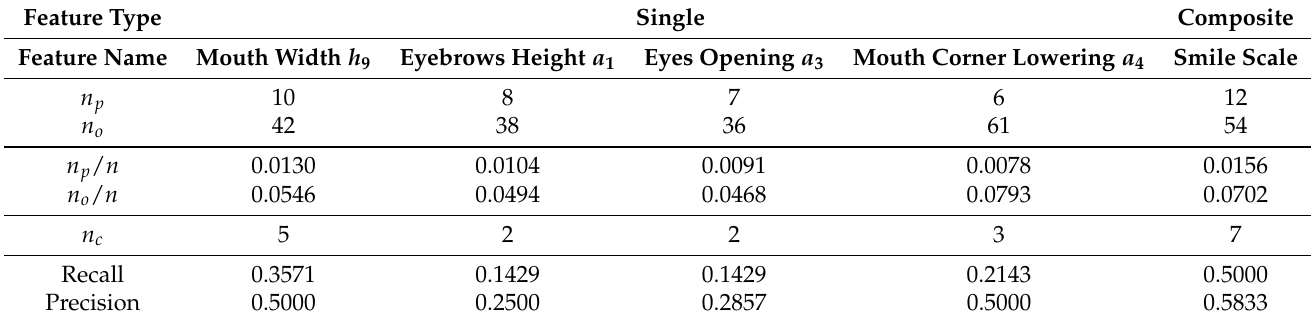
Table 6. Various parameters and ratios measured (Subject D: number of whole data n = 769, number of event points n e = 14). Feature